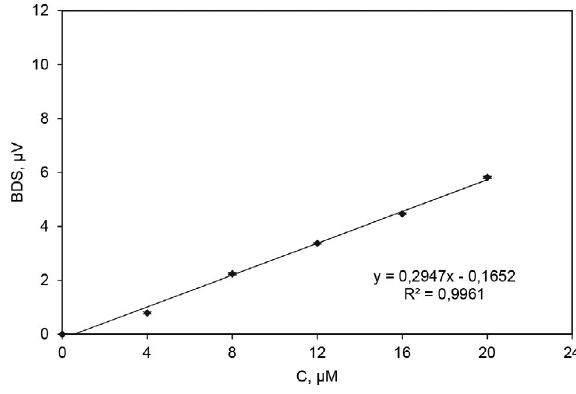
Figure 6. Calibration curve for total Fe